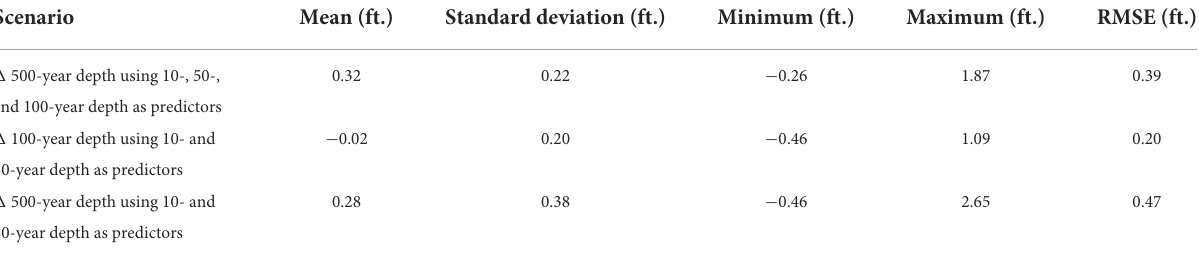
TABLE 7 Descriptive statistics and root-mean-square error of the difference ( 1 ) between the Gumbel model-based flood depth ( D ) estimation and Risk MAP-modeled D , when using D at known return periods to predict D at another known return period, for Metairie, Louisiana, study area. Scenario Mean